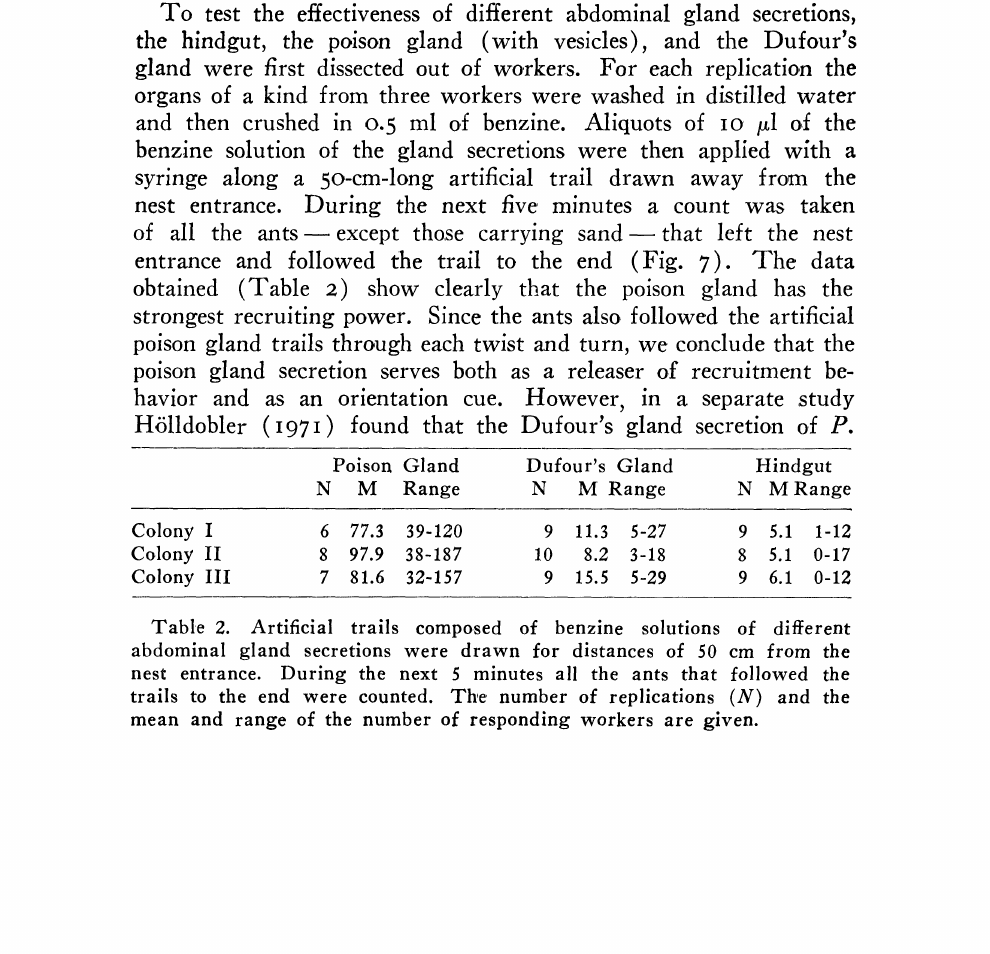
Table 2. Artificial trails composed of benzine solutions of different abdominal gland secretions were drawn for distances of 50 em from the nest entrance. During the next minutes all the ants that followed the trails to the end were counted. Th’e number of replications (N) and the mean and range of the number of responding workers are